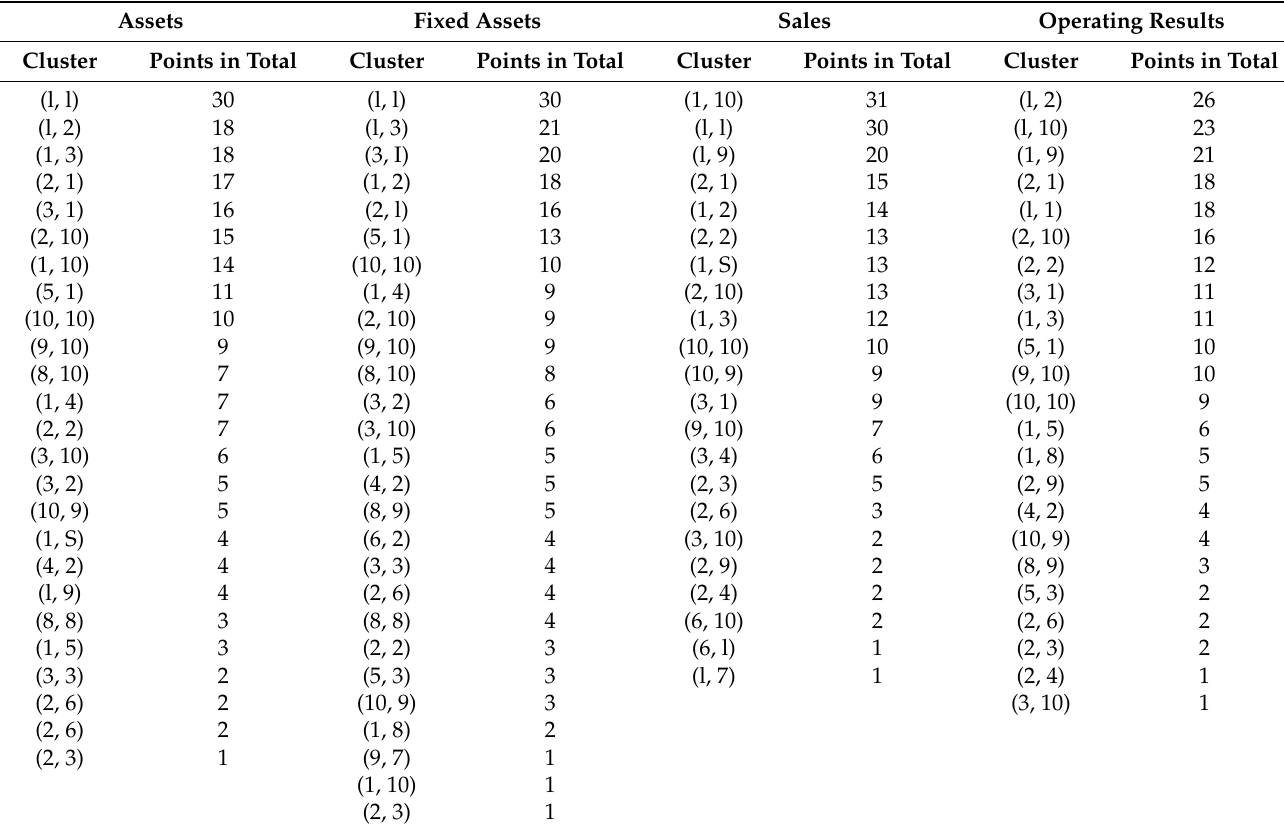
Table 29. Table with the data on the number of points for individual clusters.